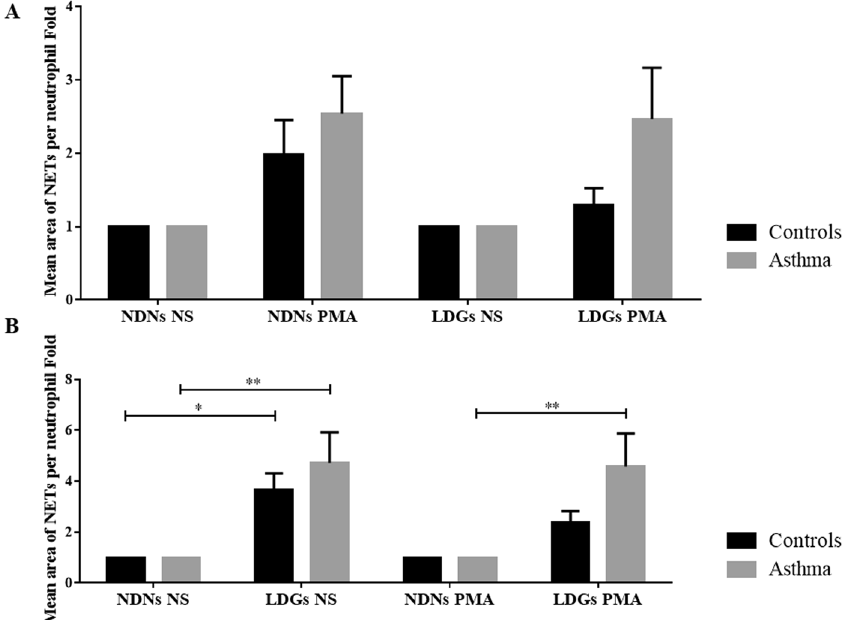
Figure 7. Fold changes of mean area of NETs per neutrophil in each layer of cells. ( A ) Results represent fold induction of the effects of PMA stimulation on the mean area of NETs per neutrophil on each layer of cells in each group of horses. Stimulation with PMA significantly increased the production of NETs in both groups of horses (p = 0.0008). Mean ± SEM for each studied population is shown. A two-way repeated measures ANOVA without Sidak’s multiple comparison post-tests has been realized in this case. ( B ) Results represent fold induction of the mean area of NETs per neutrophil by LDNs compared to NDNs in each group of horses, before and after stimulation with PMA. LDNs produced significantly more NETs than NDNs (p < 0.001). Mean ± SEM for each studied population is shown. * p ≤ 0.05 and ** p ≤